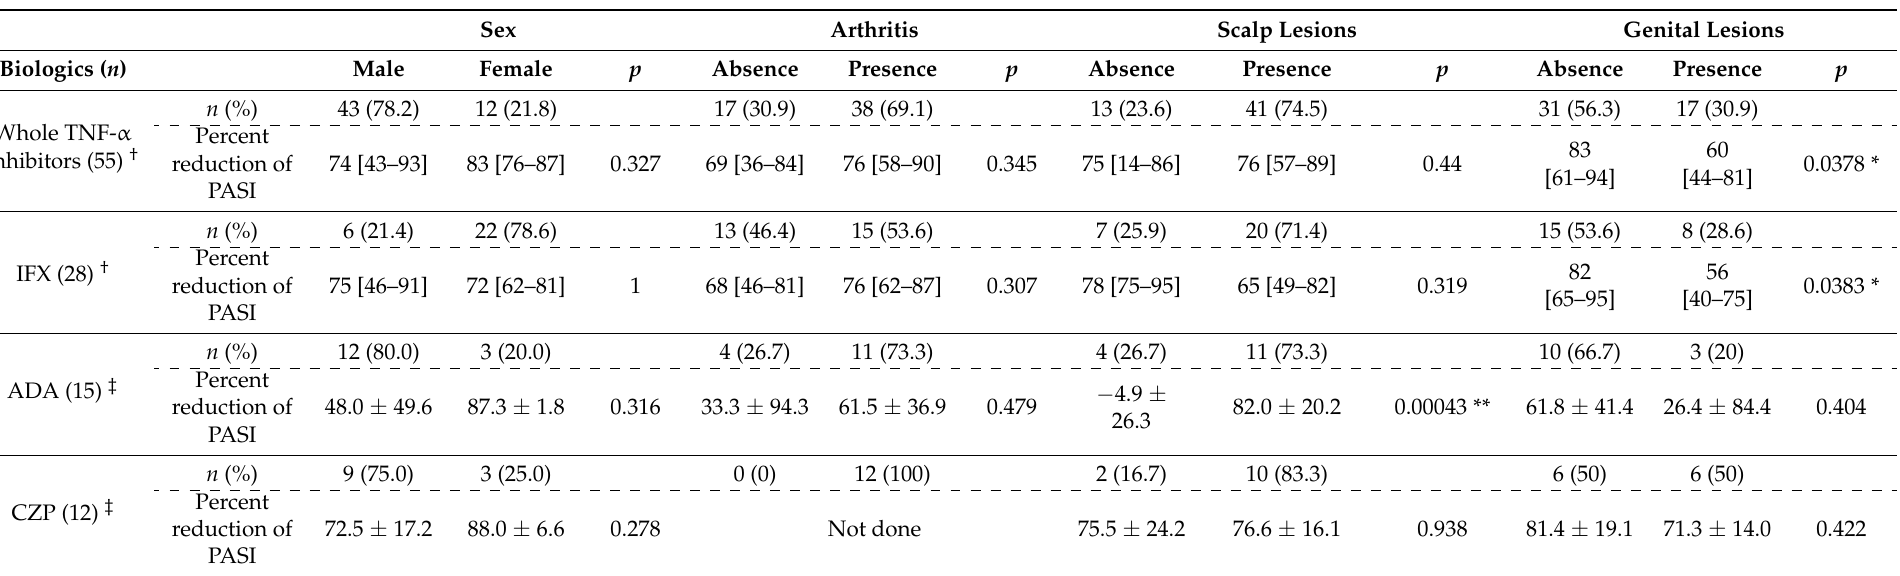
Table 7. The relationship between percentage reduction of psoriasis area and severity index (PASI) at week 52 versus sex, presence or absence of arthritis, scalp or genital